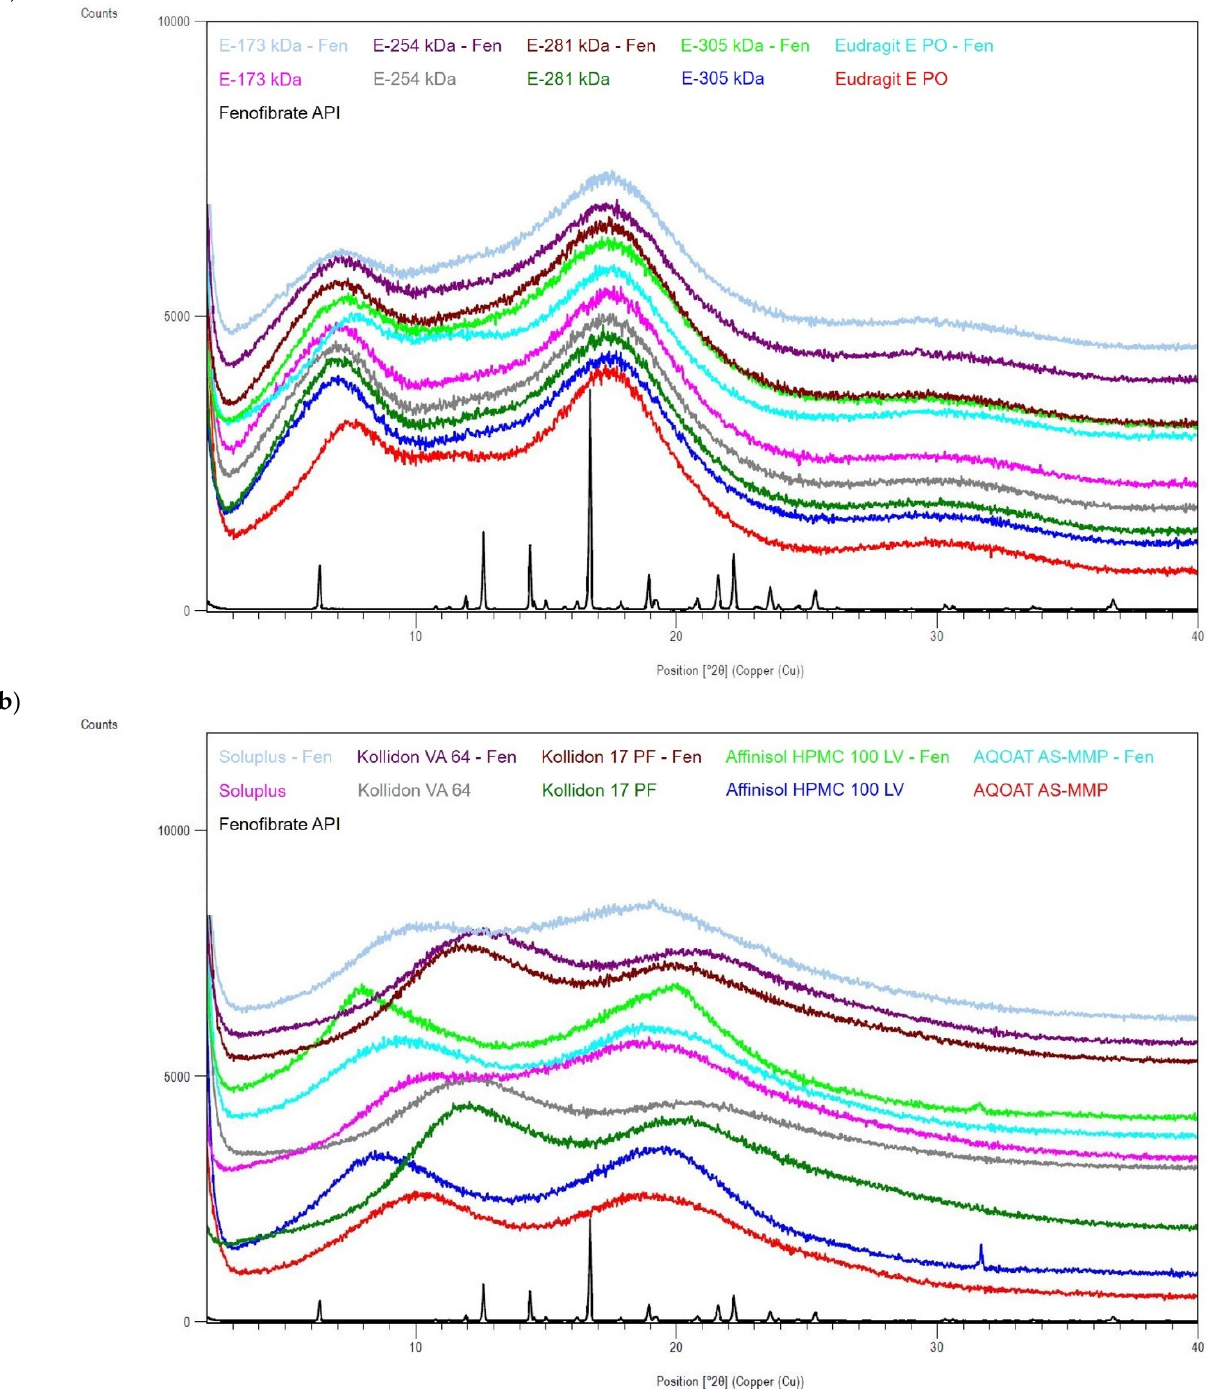
Figure 4. X-ray powder diffraction (XRPD) diffractograms of the drug substance fenofibrate, ModE copolymers, EPO and the corresponding ASDs ( a ), as well as fenofibrate drug substance, other marketed (co-)polymers (selection) and the corresponding ASDs ( b ).